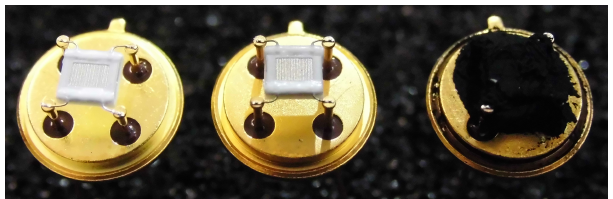
Figure 3. Socket mounted IDE structures. Left: fresh; middle: light loaded (response ∼ 3%); right: heavily loaded (response 419%, percolation threshold exceeded) (Weiss et al.,